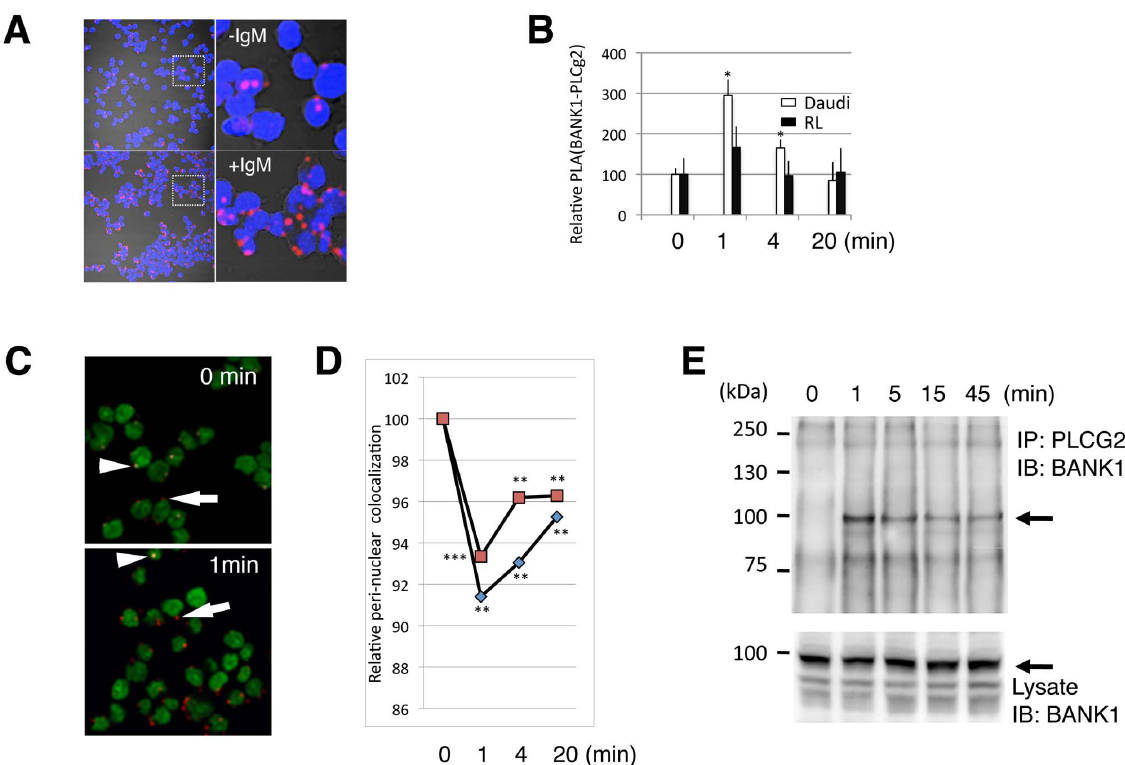
Figure 3. BANK1-PLCG2 complex formation is transient and induced by IgM stimulation. (A) Confocal images of Daudi B cells showing increase molecular proximity between endogenous BANK1 and PLCg2 proteins upon anti-IgM stimulation. The staining was done using in situ a PLA protocol with rabbit anti-BANK1 (ET-52) and mouse anti PLCg2 (Abcam). Nuclei were stained with DAPI in blue. The confocal images (PLA signals) were taken with a pinhole of 2.5 (Zeiss Plan-Apochromat 63 6 oil objective). Upper panel, non-stimulated cells. Low panel, cells stimulated for 1 minute with anti-human IgM-F(ab’)2. To the right are shown digital magnifications. (B) Time variation of PLA BANK1-PLCg2 interaction upon stimulation with anti-IgM in two human B-cell lines, the Burkitts derived Daudi and the non-Hodgkins lymphoma derived RL. Results are shown as the mean from three independent experiments. Error bars represent the SD from the mean. *P , 0,05 based on Students test comparing stimulated cells versus time 0 (non stimulated cells).(C) Merge confocal images (pinhole=1) of Daudi cells showing the nuclei in green and the BANK1-PLCg2 PLA interaction in red to permit co-location analysis. PLA signals close to the nucleus appeared as yellow dots (arrowheads) and when localize in the periphery of the cell as red dots (arrows). (D) Time course upon anti-IgM stimulation of co-localization between the PLA signal and the nucleus. Quantification was done using the overlap coefficient after Manders because this coefficient is insensitive to differences in signal intensities between channels. After one minute of stimulation the co-localization decreases suggesting a translocation of the BANK1-PLCg2 complex. The graft shows two independent experiments, each point represents the analysis of at least 300 cells.**,P , 0,01;***P , 0,001 based on Students test comparing stimulated cells versus time 0 (non stimulated). (E) Immunoprecipitation of the BANK1-PLCg2 complex in Daudi cells. Anti-PLCg2 immunoprecipitates (above) and total cell lysate (below) were analyzed by immunoblotting with anti-BANK1 antibody (BANK1-ET-52). The position of the BANK1 protein is indicated by arrows. (Y484 and Y488) that are predicted to form a strong SH2 binding motif. Because the prey clones also contain proline rich binding motifs (SH3), we analyzed the effect of BANK1 proline substitutions in our binding assay. The mutated sites have a variable degree of conservation on orthologous proteins, thus, the proline P20 is poorly conserved while the sequence surrounding the prolines P611 and P612 is highly conserved (Figure 6B). We expressed the mutated BANK1 proteins in cells transfected with the kinase constitutive active form of BLK (BLK–YF) and PLCg2 (Figure 6C). The association was measured by immunoprecipita- tion using the anti-PLCg2 antibody and the level of BANK1 tyrosine phosphorylation was estimated with the anti-pan-tyrosine antibody (Figure 6D). Substitution of Y484 and Y488 to F led to an overall decrease of tyrosine phosphorylation of BANK1 (lane 2, first row), the substitution of Y125 did not influence the BLK- mediated phosphorylation and the substitution of Y146 only marginally reduced the level of tyrosine phosphorylation, indicat- ing that Y484 and/or Y488 were phosphorylated by the